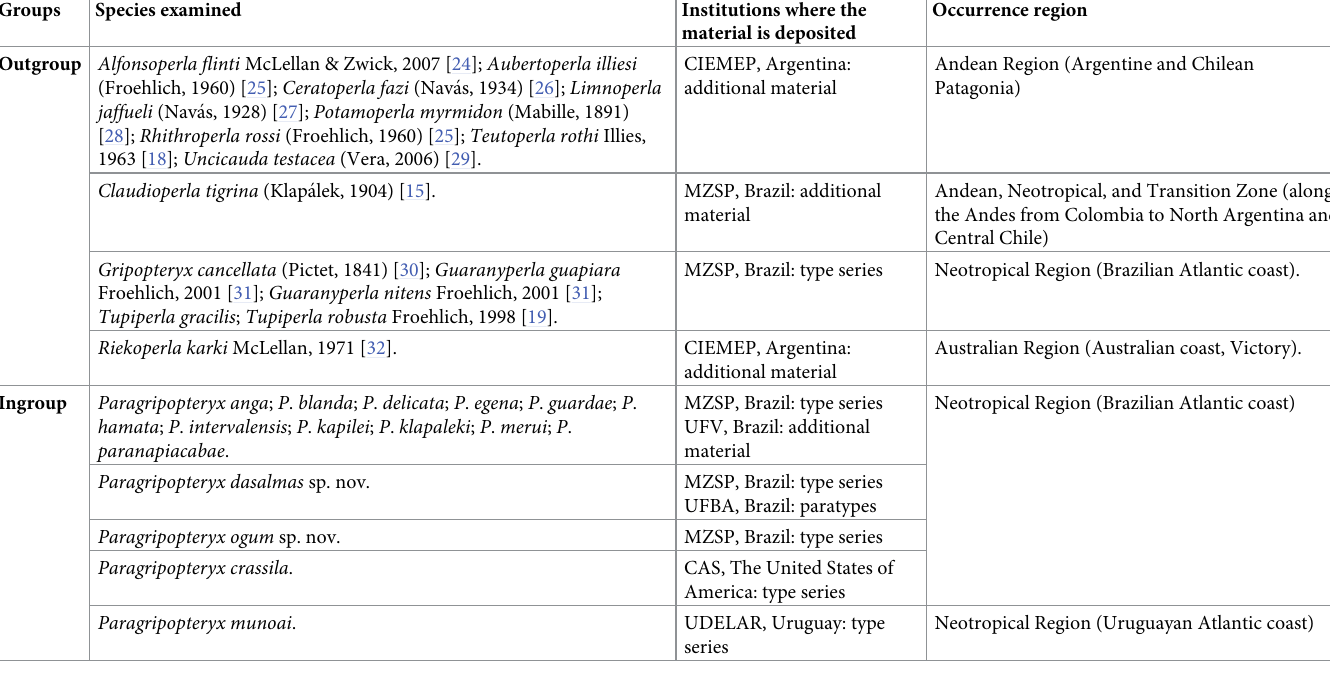
Table 1. Species studied for the phylogenetic proposition, the institutions where the specimens are deposited, and biogeographical occurrences. Andean Region, Transition Zone, and Neotropical Region ( sensu Morrone